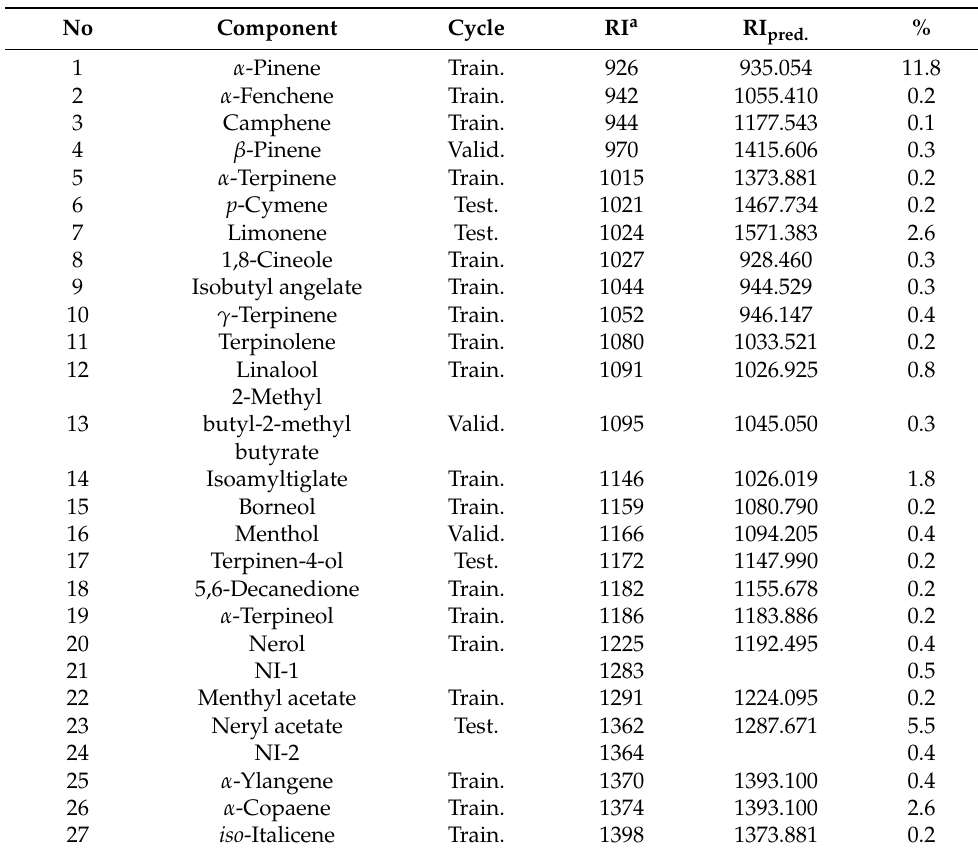
Table 1. Chemical composition of H. italicum essential